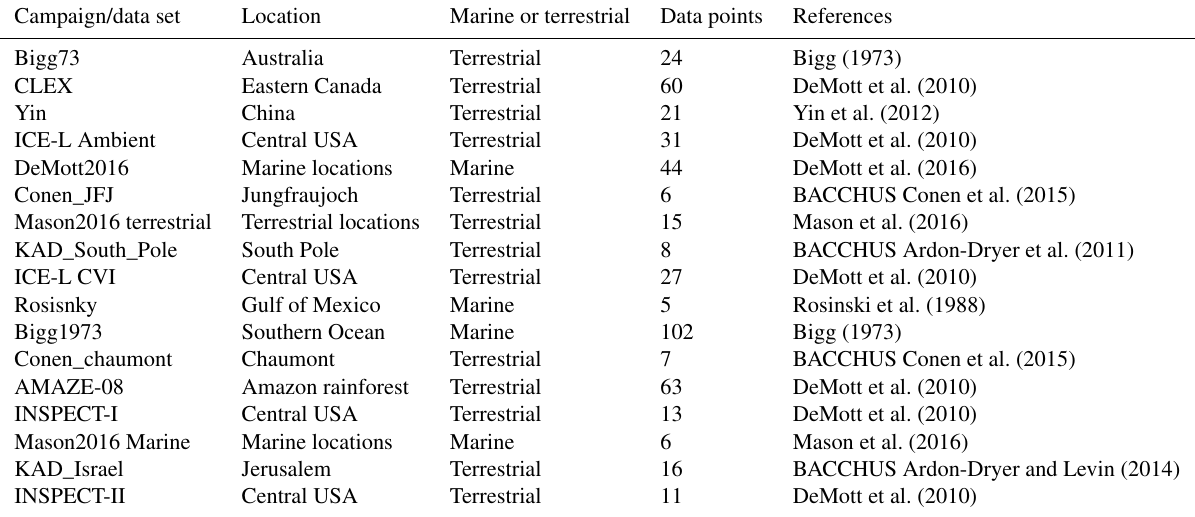
Table C1. Table of the data sets used for this study. Campaign/data